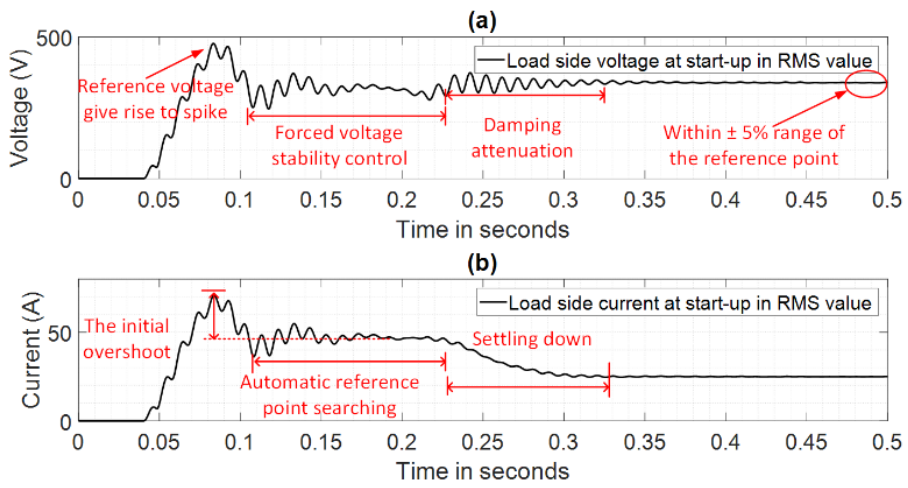
Figure 9. System starts up. ( a ) Preliminary voltage from the fixed load, ( b ) preliminary current from the fixed load.